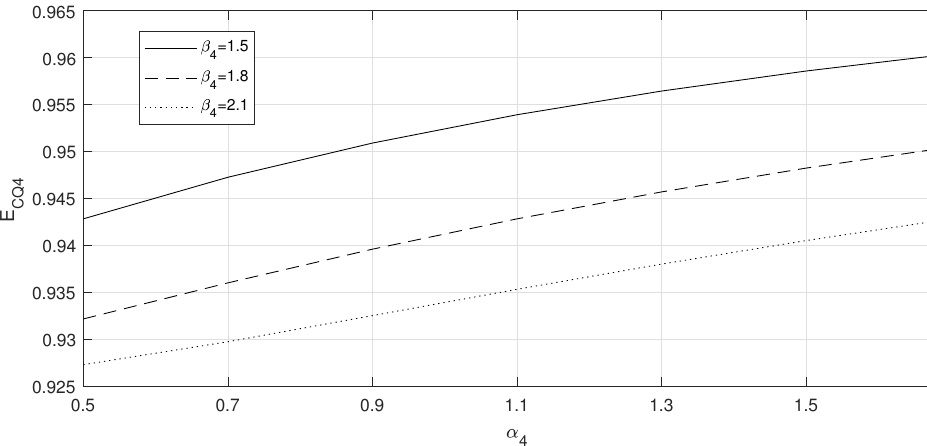
Figure 11. Expected customer loss in Queue-4 on α 4 vs. β 4 .